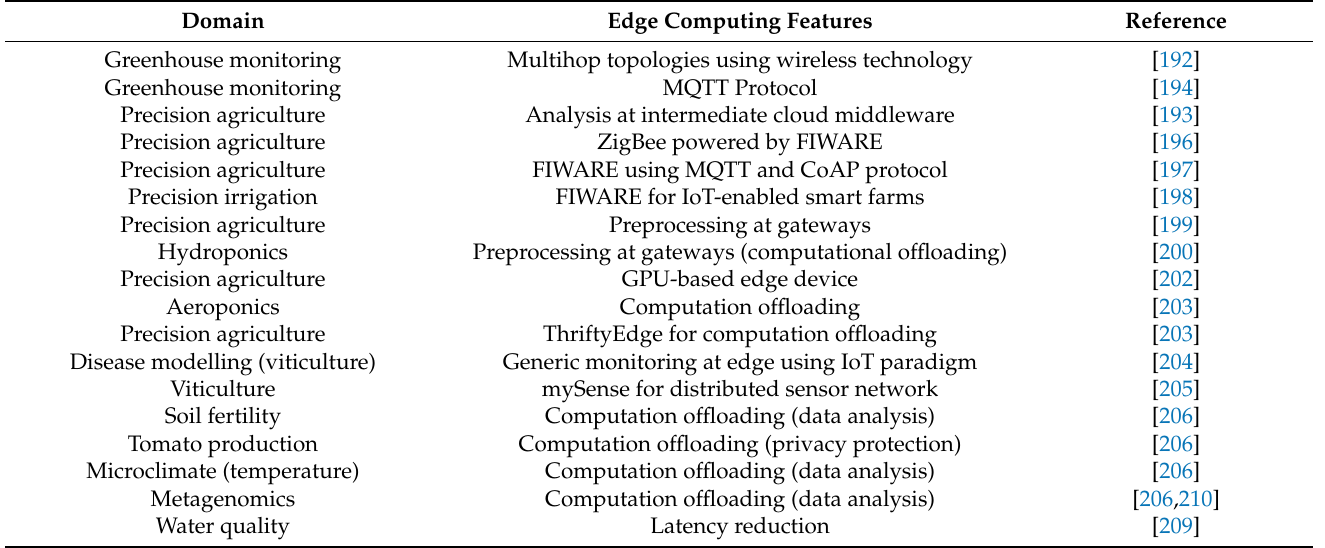
Table 4. Usage of edge computing techniques in the domain of